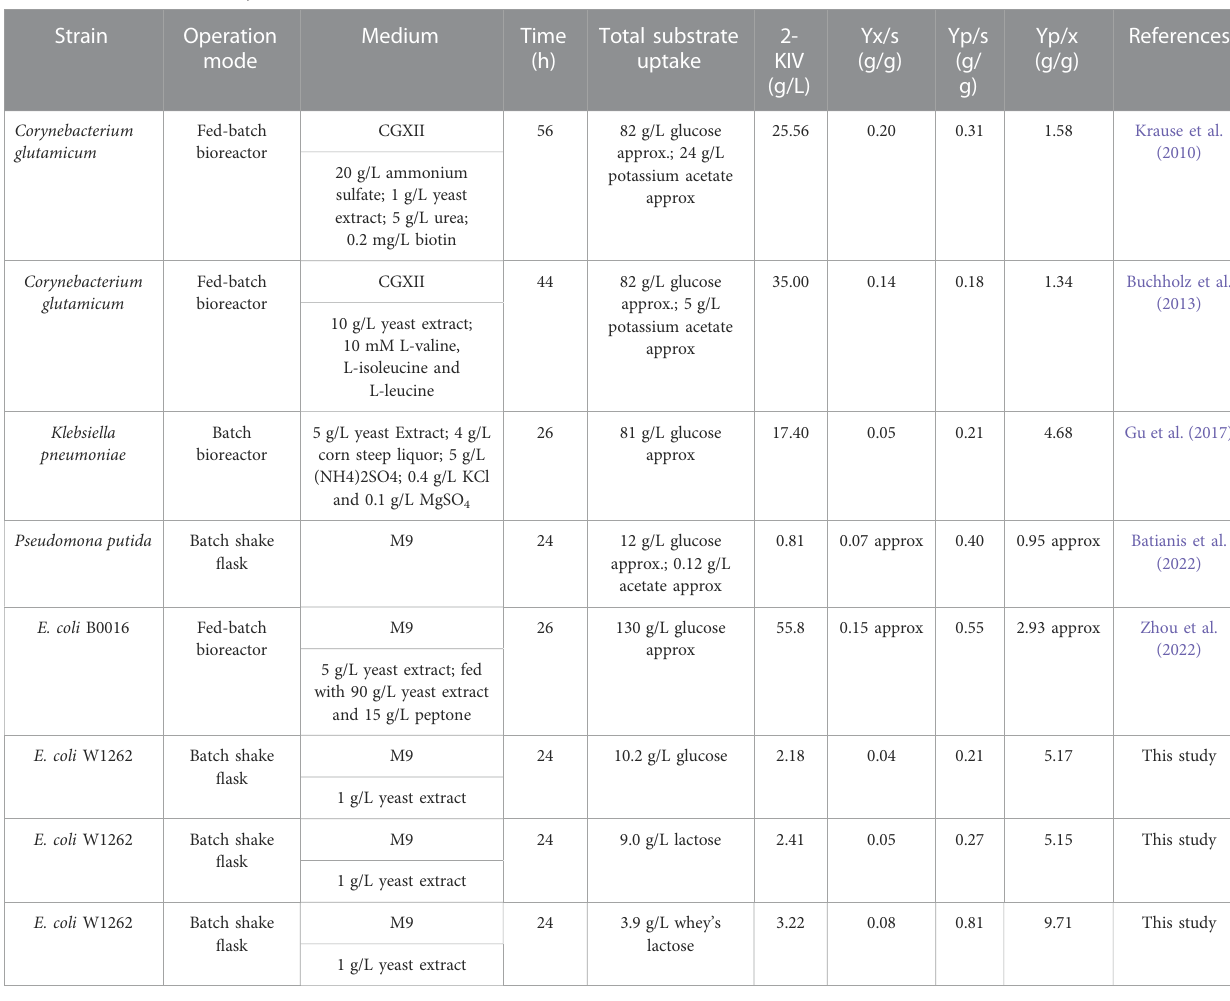
TABLE 2 Production of 2-KIV by different